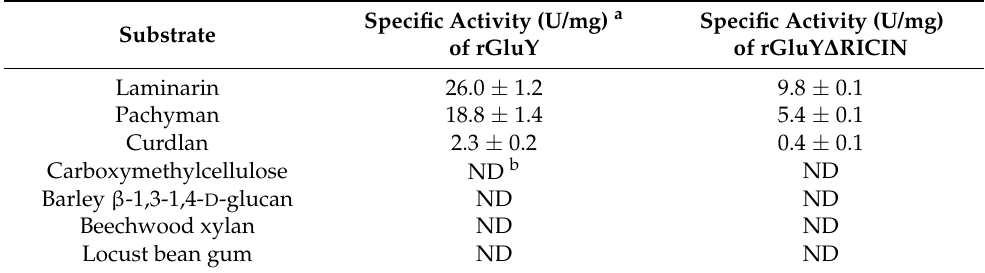
Table 2. Biocatalytic activity of rGluY and rGluY ∆ RICIN toward different polysaccharides.